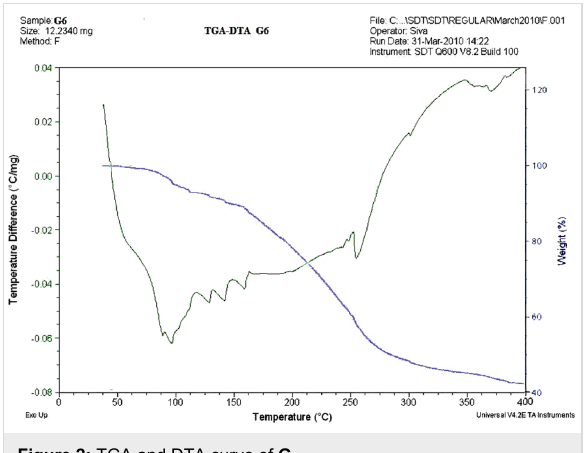
Figure 2: TGA and DTA curve of G 6